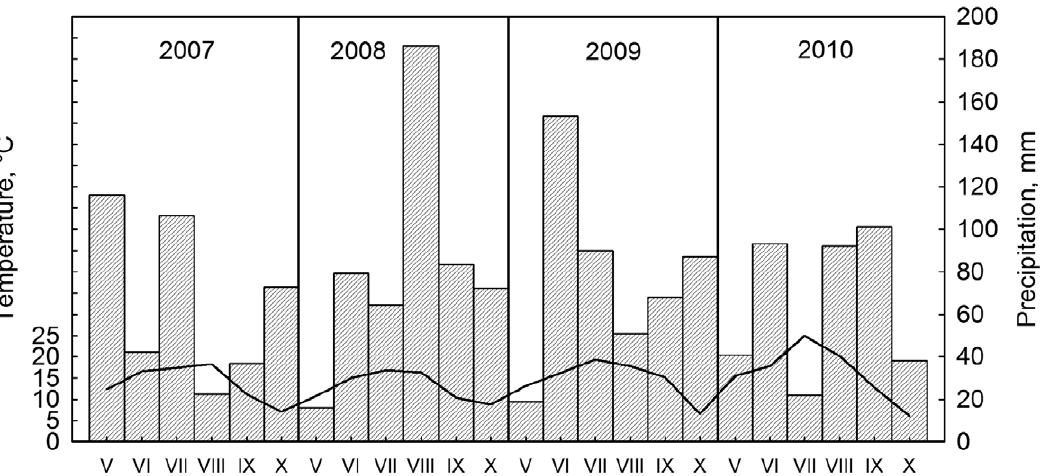
Figure 1. Monthly mean air temperature (line) and precipitation (columns) of the growing seasons of the study period.